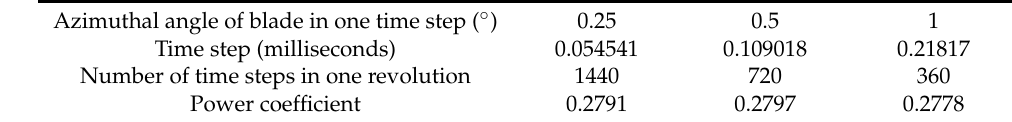
Table 4. Different time steps for verification.